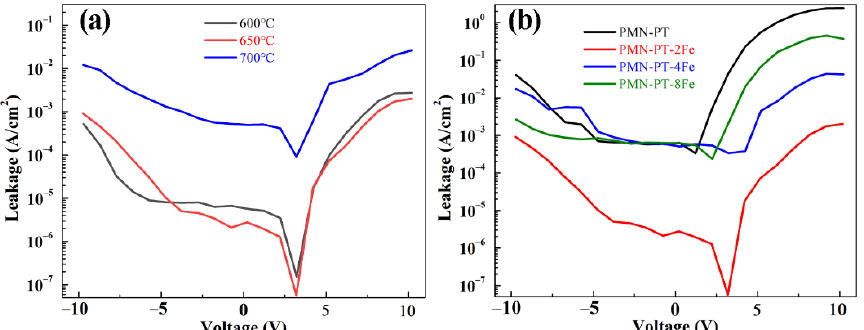
Figure 4. ( a ) Leakage current density of PMN-PT-2Fe thin films annealed at varied temperatures, ( b ) Leakage current density of PMN-PT-xFe thin films with different doping concentrations of Fe element.